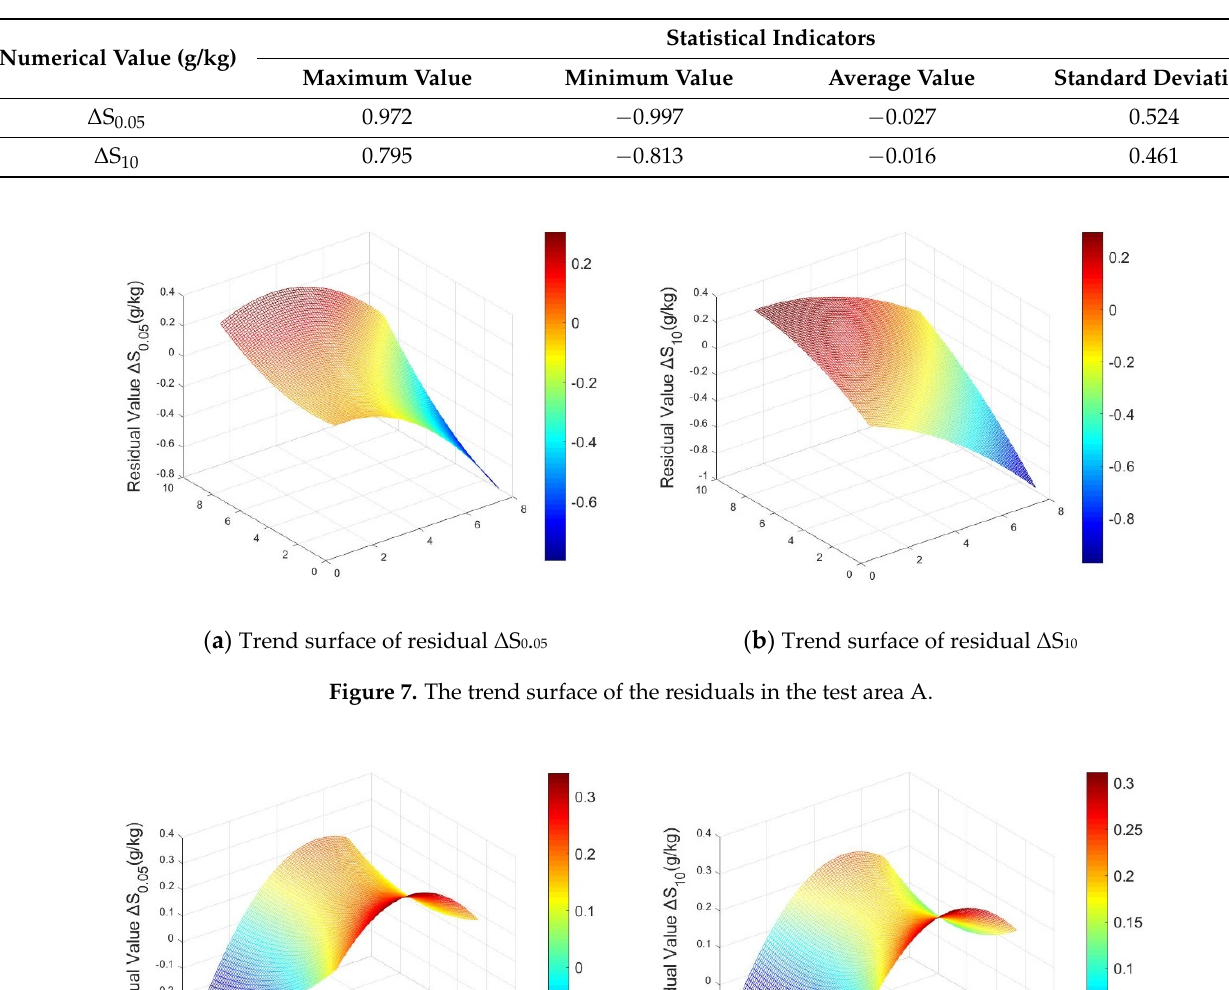
Table 5. Statistical characteristics of residuals error ∆ S 0.05 and ∆ S 10 .